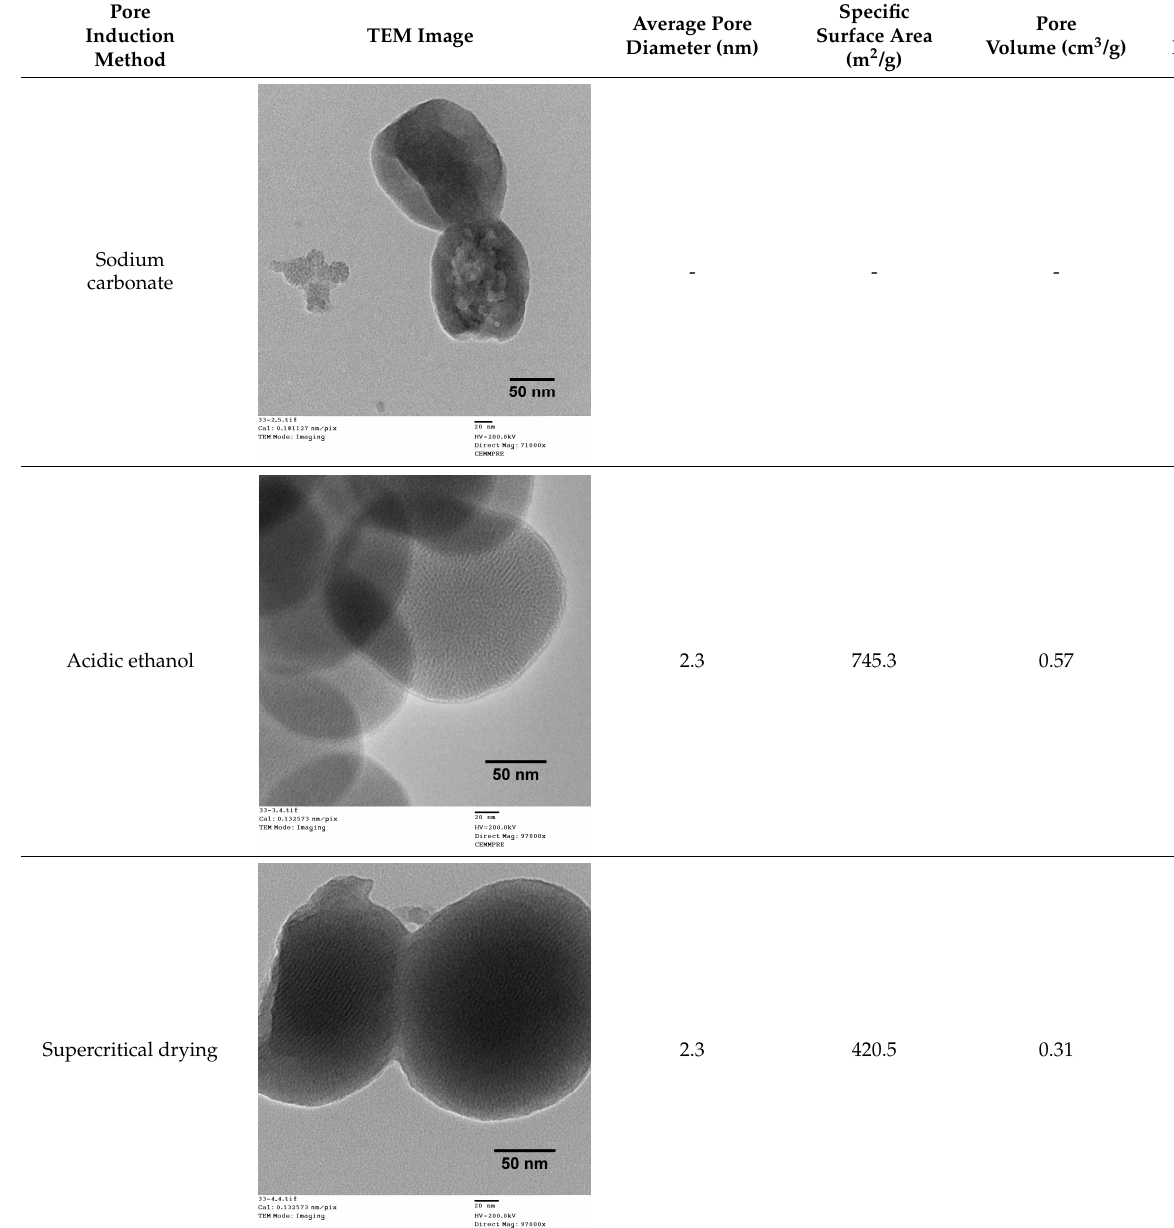
Table 1. Physicochemical characterization by transmission electron microscopy (TEM image— scale bar = 50 nm), Brunauer–Emmett–Teller/Barrett–Joyner–Halenda and zeta potential analyses of TMSNs obtained after treatment with sodium carbonate, acidic ethanol, and supercritical